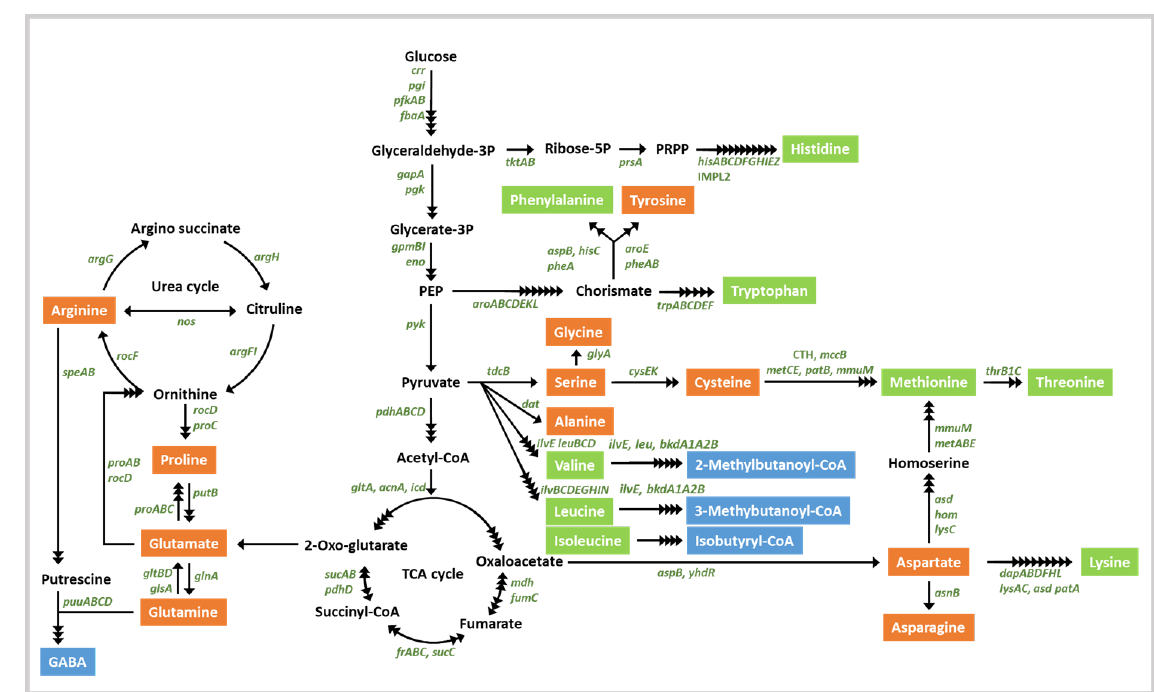
Figure 3. Predicted amino acid synthesis pathways in B. siamensis strain B28. Enzyme-encoding genes are displayed in green. Essential amino acids, non-essential amino acids, and other metabolites are green, orange, and blue-boxed, respectively. The black arrows indicate potential enzymatic reactions.